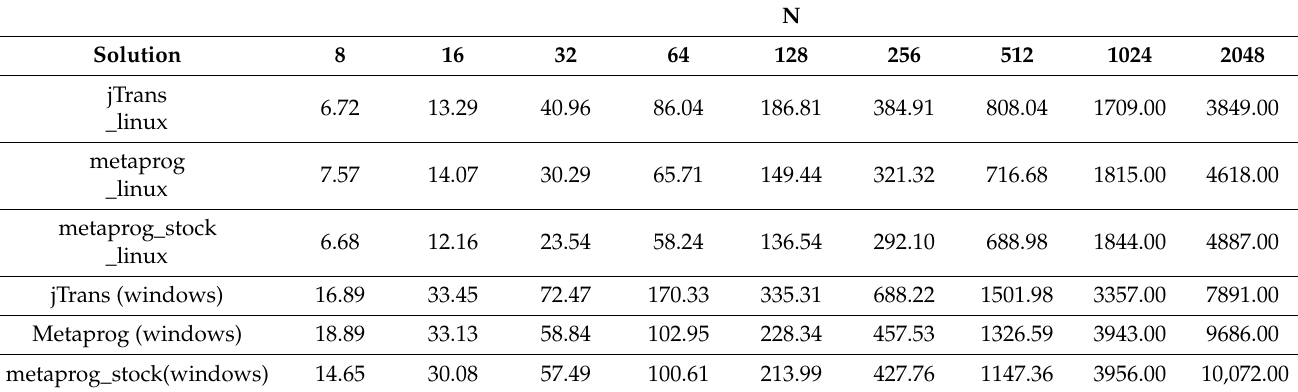
Table 1. Execution times for three solutions and two runtime environments: Windows and Linux (values in ms).